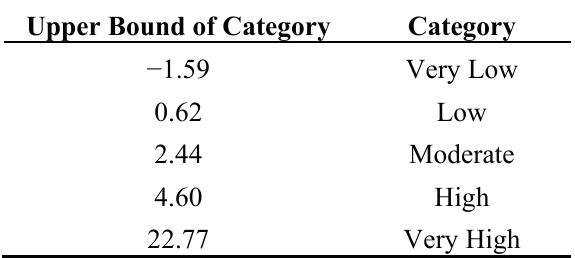
Table 3. Vulnerability categories and their respective quantile break upper bound